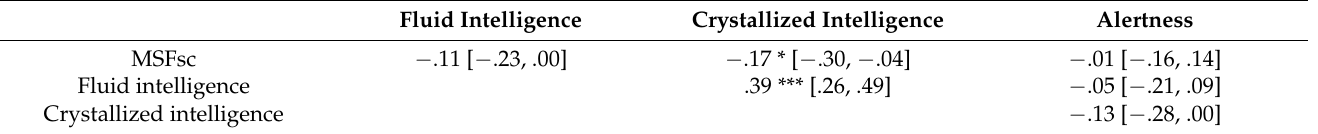
Table 2. Pearson correlations with 95% confidence intervals between study variables. Fluid